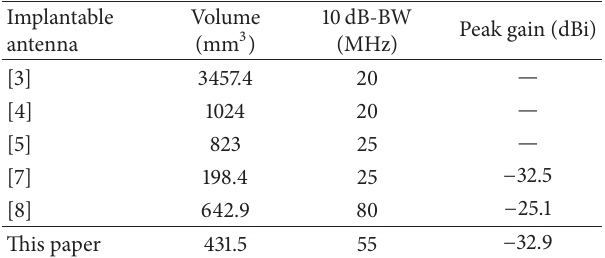
Table 2: Characteristic comparisons of the similar implantable